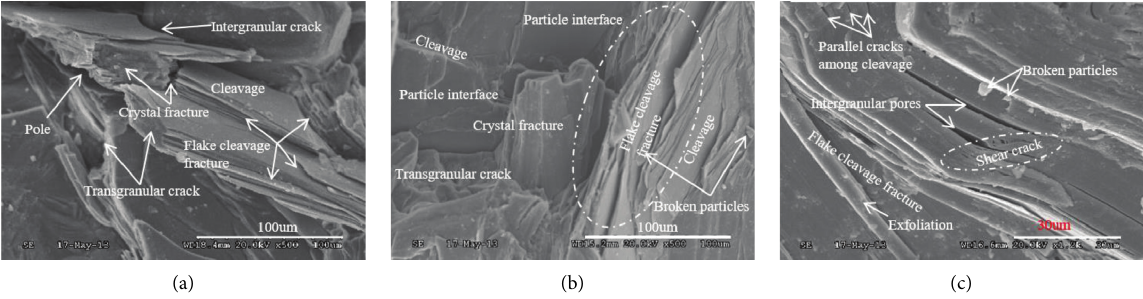
Figure 3: Main microfeatures of biotite. (a–c) Flaky fractures in granite